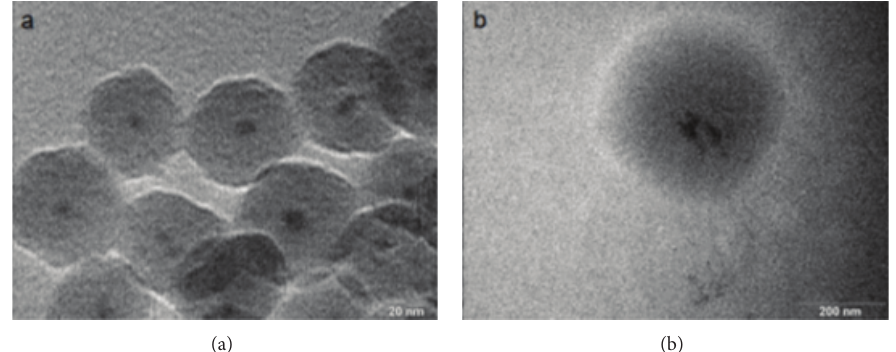
Figure 2: TEM images of samples of good silica coating of QDs under the suitable adjustment of conditions. (a) The size of silica is 40 nm; (b) the size of silica is 400 nm.